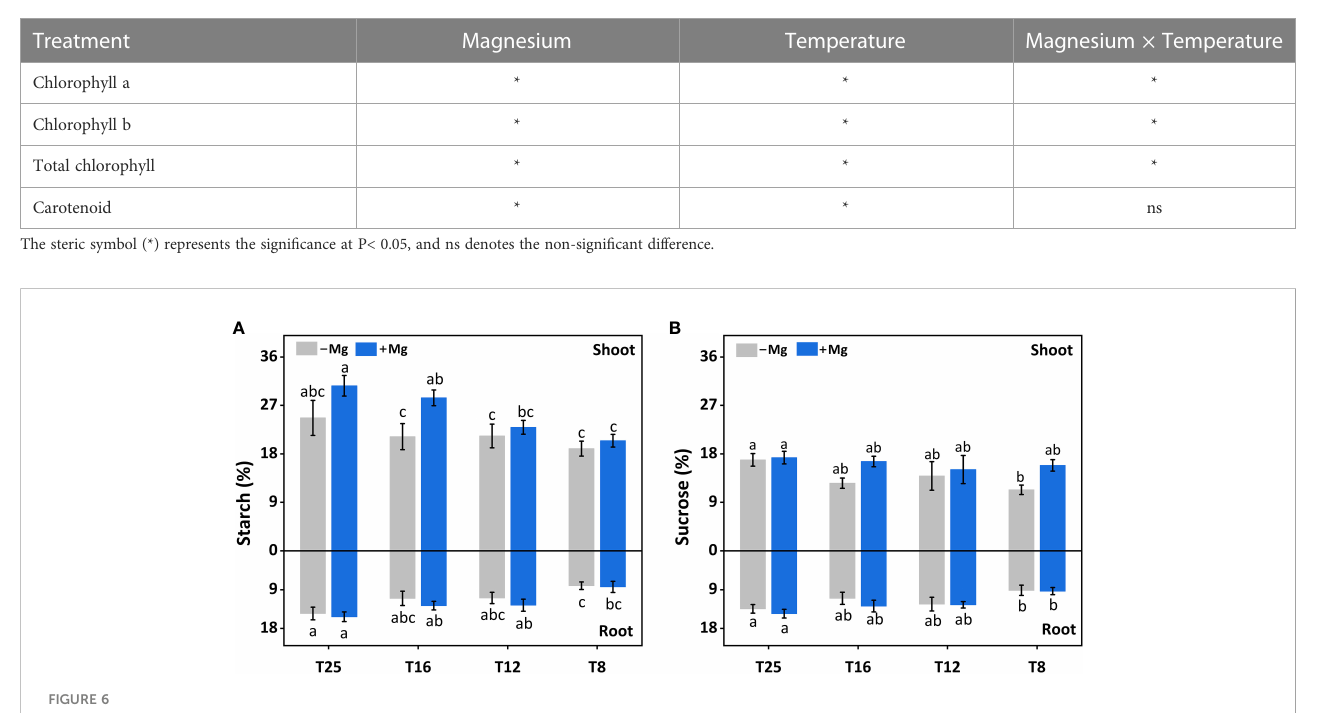
FIGURE 6 Effect of Mg application on carbohydrate of tobacco plant under different temperature. (A) shoot starch content and root starch content; (B) shoot sucrose content and root sucrose content. The different letters above the bars are indicating signi fi cant difference (Duncan P